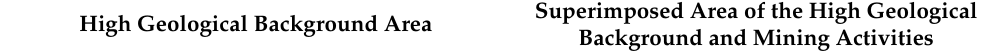
Table 3. Matrix analysis matrix of farmland soil heavy metals.